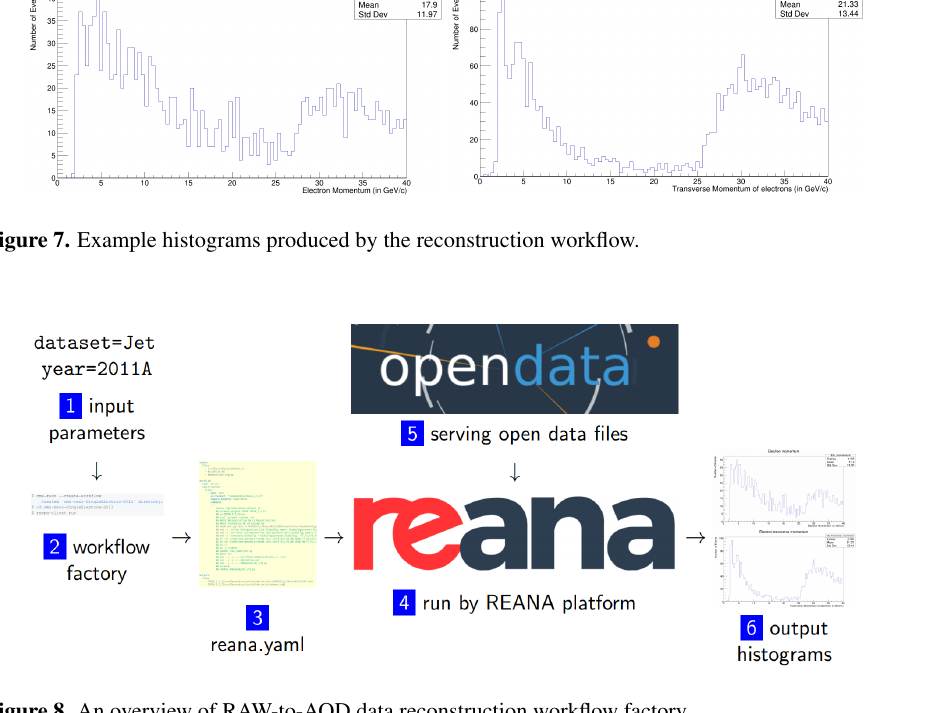
Figure 8. An overview of RAW-to-AOD data reconstruction workflow